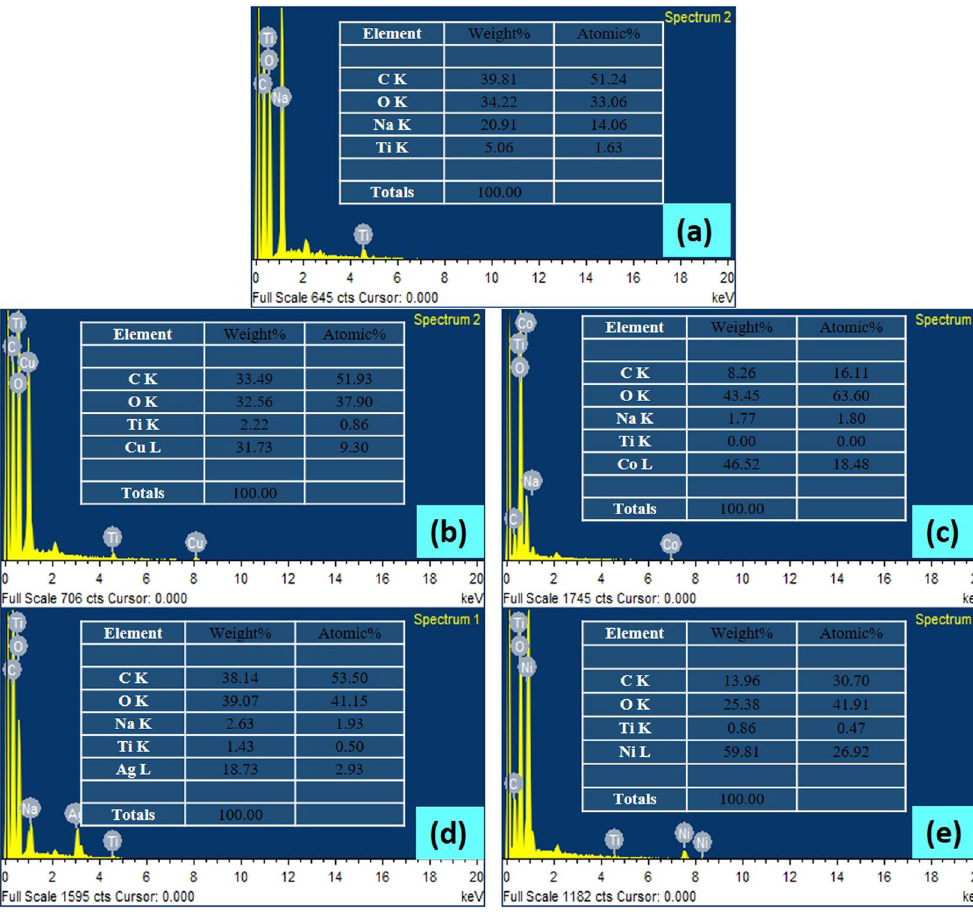
Figure 5. EDS of pure CS-TiO 2 -15 fibers ( a ), Cu/CS-TiO 2 -15 ( b ), Co/CS-TiO 2 -15 ( c ), Ag/CS-TiO 2 -15 ( d ) and